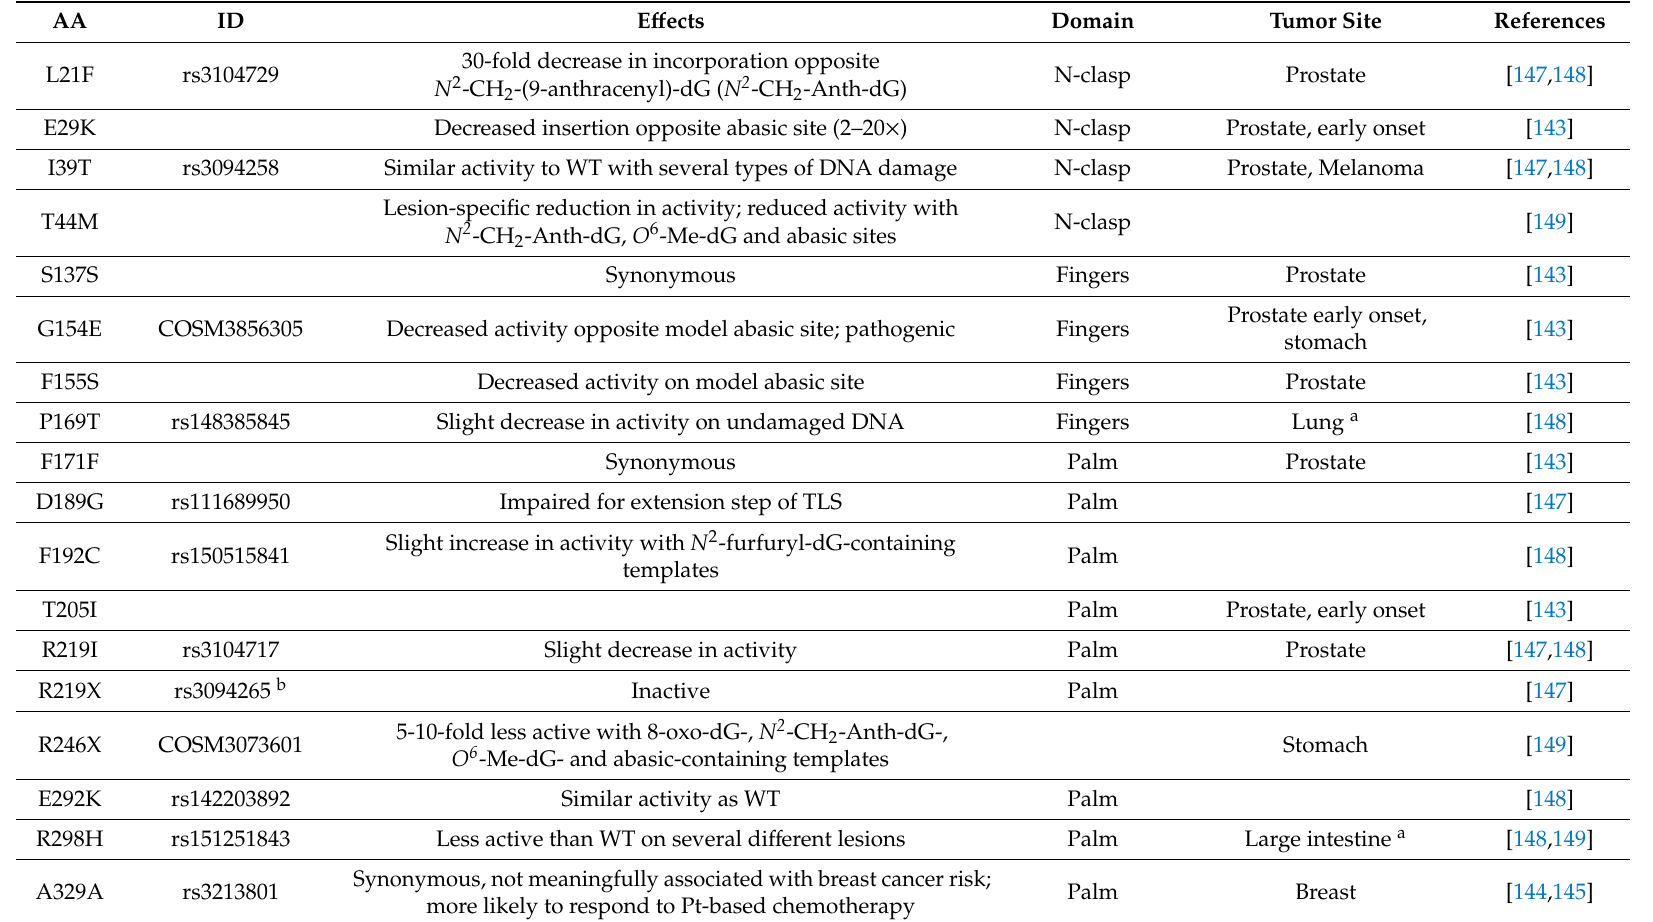
Table 1. POLK single nucleotide